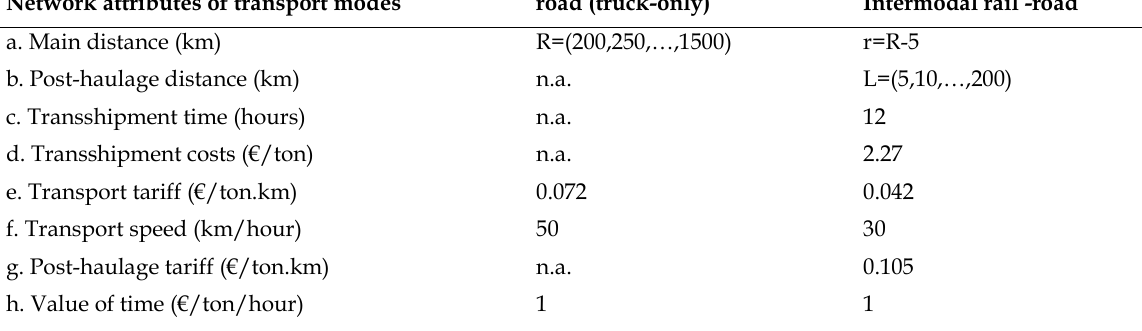
Input used in the models Network attributes of transport